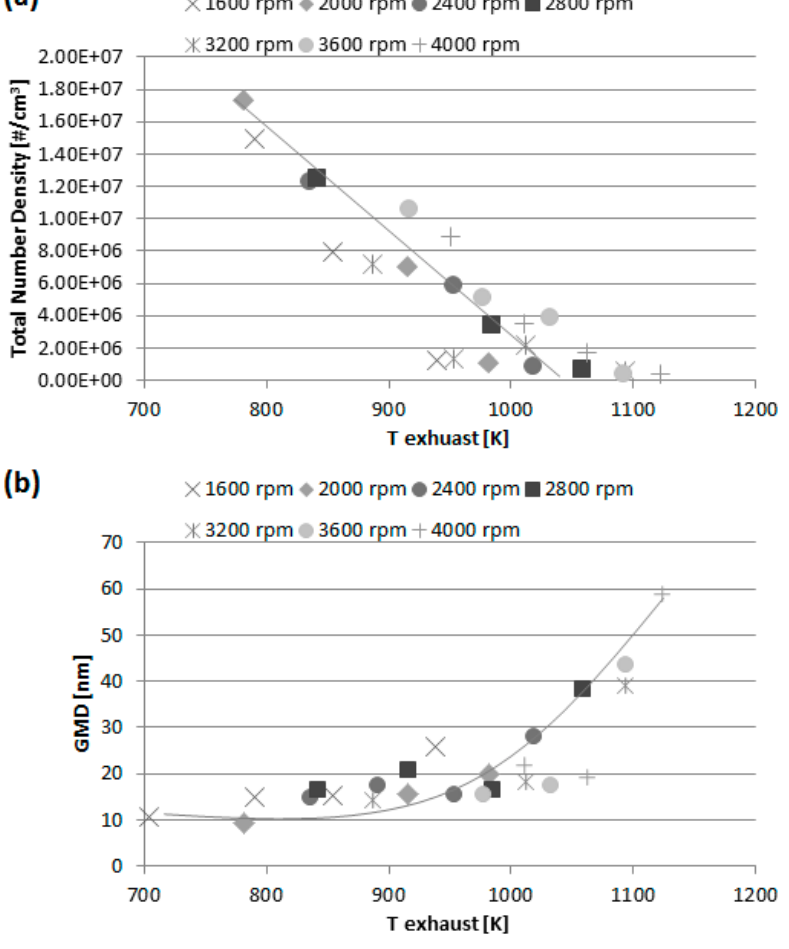
Figure 9. Total particle number density ( a ) and GMD ( b ) as functions exhaust gas temperature.